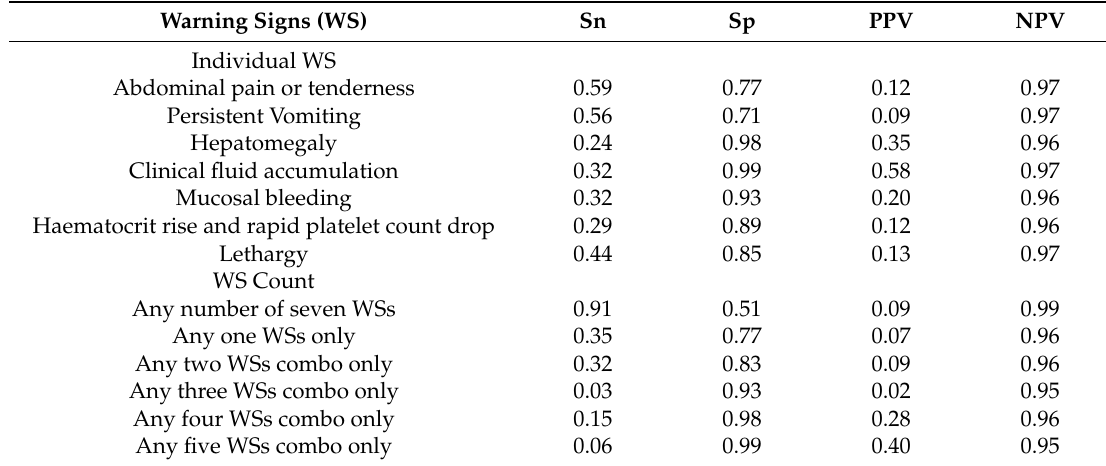
Table 5. Performance of World Health Organization (WHO) Warning Signs (WS) in predicting SD.